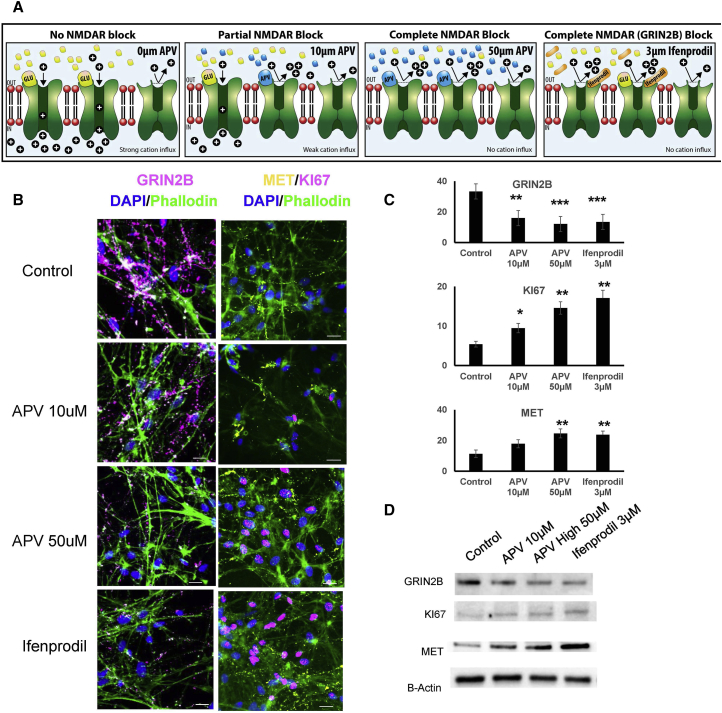
Pharmacological Block of NMDAR Impairs Neuronal Differentiation(A) Diagram showing the mechanism of action of APV and ifenprodil on NMDAR.(B) Representative ICC images of GRIN2B; MET, and KI67 immunostaining on D30 control neurons either untreated or treated with APV- or ifenprodil-supplemented medium every 72 hr. Scale bars represent 25 μm.(C) Quantification of GRIN2B, MET, and KI67 immunopositive signals shown in (B). Error bars denote SEM; n = 7 independent experiments, with each data point representing quantifications of coverslips obtained from separate cultures of each cell line. ∗p < 0.05; ∗∗p < 0.01; ∗∗∗p < 0.001.(D) Western blot of GRIN2B, KI67, MET, and β-actin using lysates obtain from control D30 neurons differentiated in APV or ifenprodil-supplemented medium.See also Figure S5.